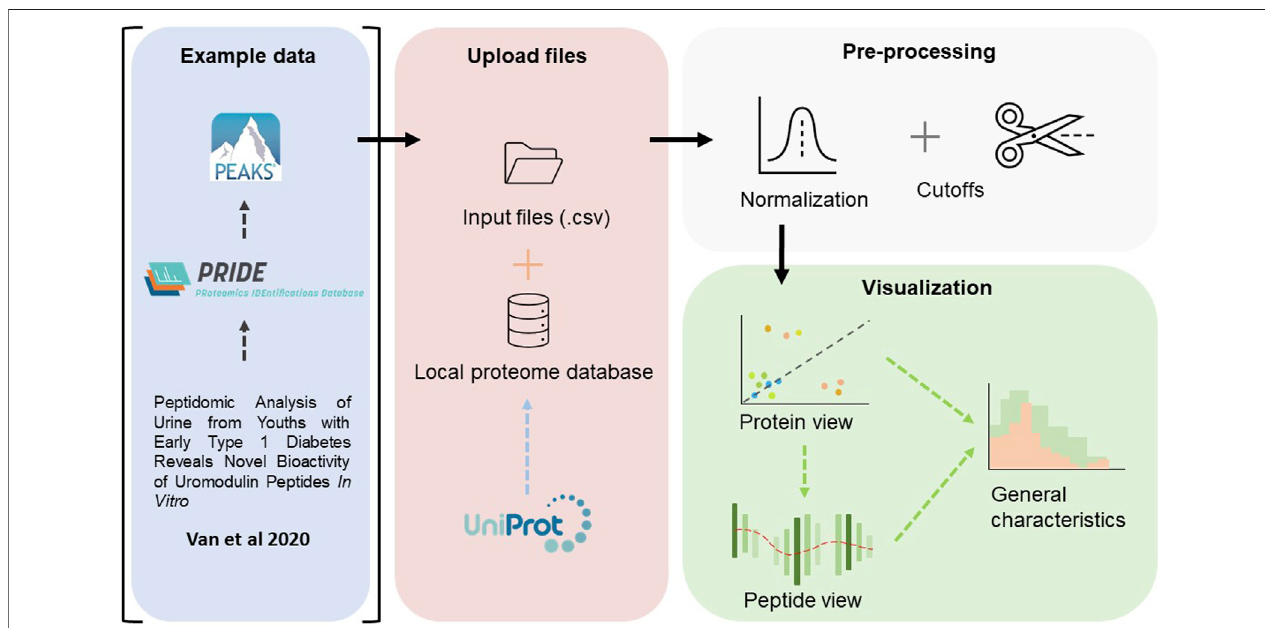
FIGURE1| Anoverviewofthework fl owperformedinthisstudy.Theraw fi les,depositedbyVanetal.(2020),werefetchedfromProteomeXchangeConsortium via thePRIDEpartnerrepository,andsearchedagainstahumanproteomedatabaseusingPEAKSXpro.InPeptimetric,theinput fi lesarematchedagainstalocalproteome database which was fetched from UniProt. Normalization and cutoffs are applied to the dataset. The data is visualized in a protein view, which in turn may be used to generate a peptide view. An overview of some general characteristics may also be generated for either the complete proteome or the selected